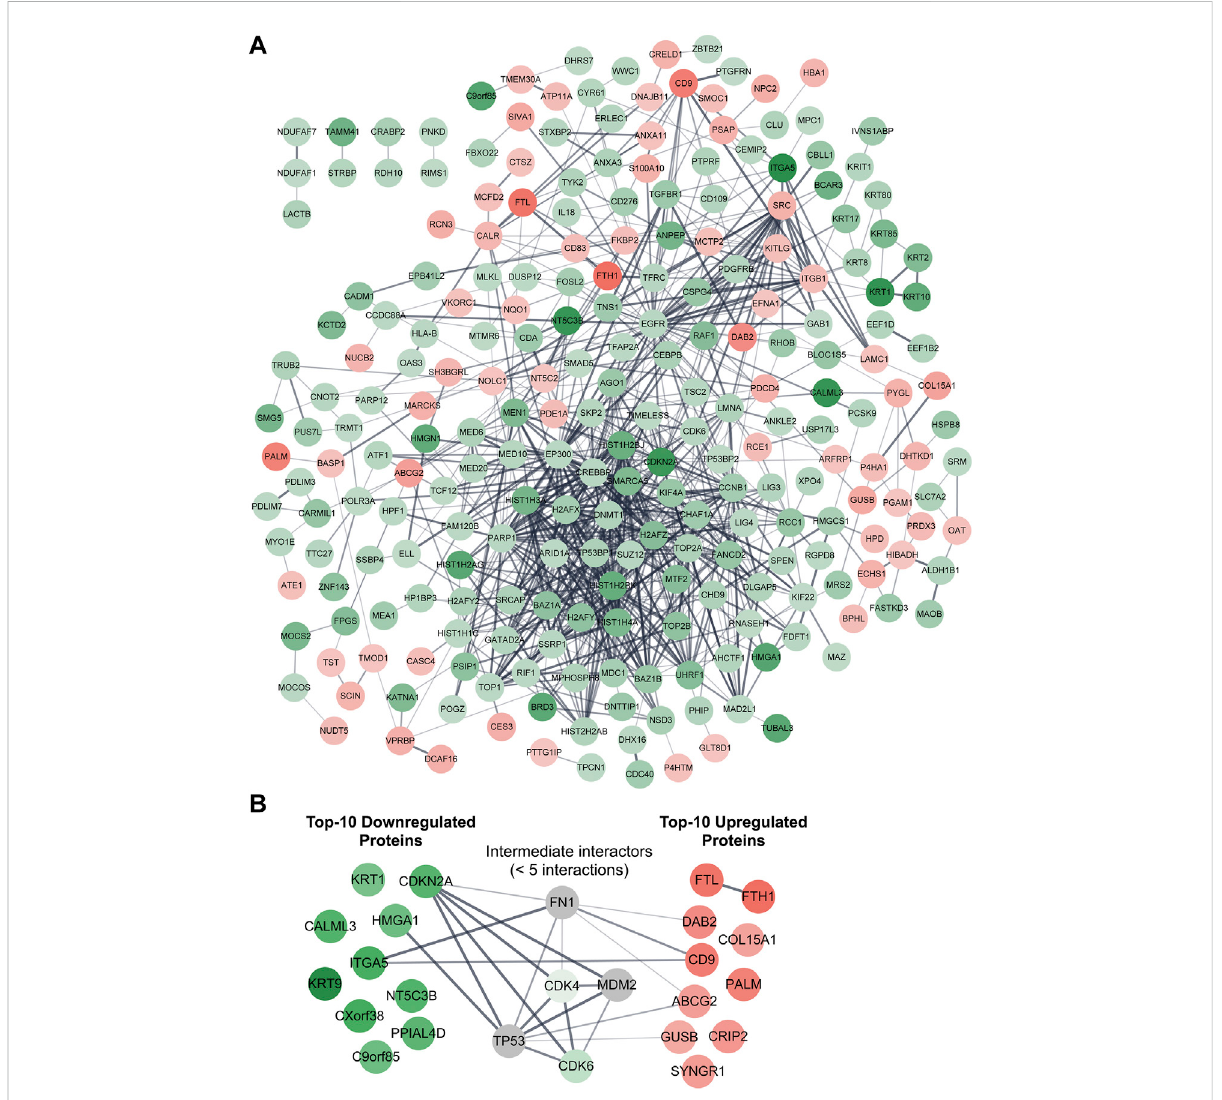
FIGURE 4 PPI network analysis of differentially expressed proteins identi fi ed in the ZIP8-KO cell model. Functional and physical interactions of all 286 (A) or 20 top-10 upregulated/downregulated (B) proteins were subjected to STRING analysis. Disconnected proteins are excluded in the network of (A) but included in (B) . Proteins within fi ve interactions (max number of interactors to show = < 5) are included in (B) . The thicker the line between two connected proteins indicates a higher con fi dence level of the interaction. Downregulated and upregulated proteins are highlighted in green and red, respectively; proteins highlighted in grey represent proteins that are not differentially